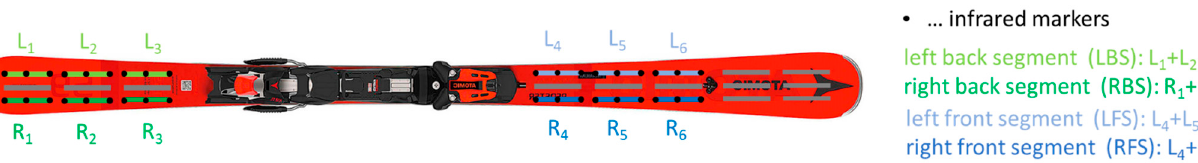
Figure 3. The PyzoFlex ® ski prototype with the corresponding left (L 1 , . . . , L 6 ) and right (R 1 , . . . , R 6 ) sensor row. There were three infrared markers (black dots) that were instrumented per sensor, resulting in a total of 36 markers. The segments were grouped into posterior (LBS: left back segment, RBS: right back segment) and anterior deflection segments (LFS: left front segment, RFS: right front segment).